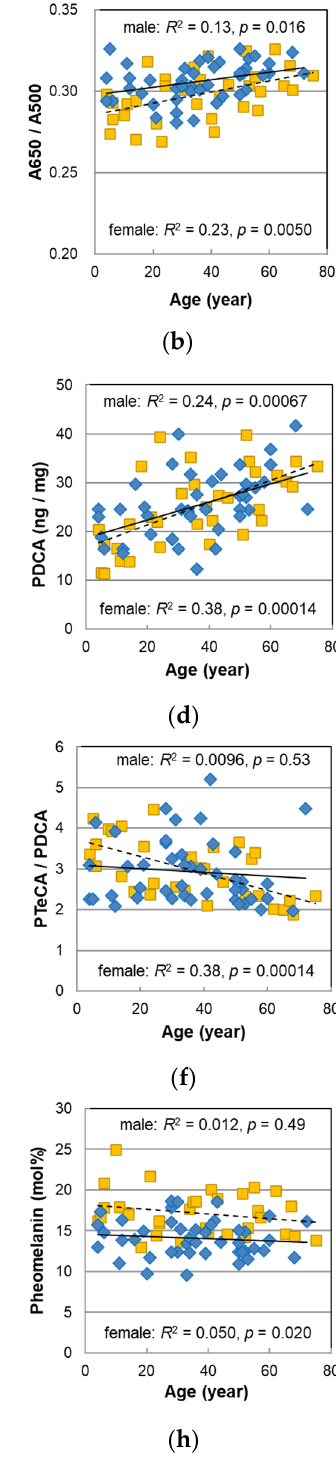
hair. ( e ) Level of pyrrole-2,3,4,5-tetracarboxylic acid (PTeCA) in hair. ( f ) The ratio PTeCA/PDCA. ( g ) 5,6-dihydroxyindole (DHI) mol% in eumelanin of hair. ( h ) Pheomelanin mol% in hair. Lines